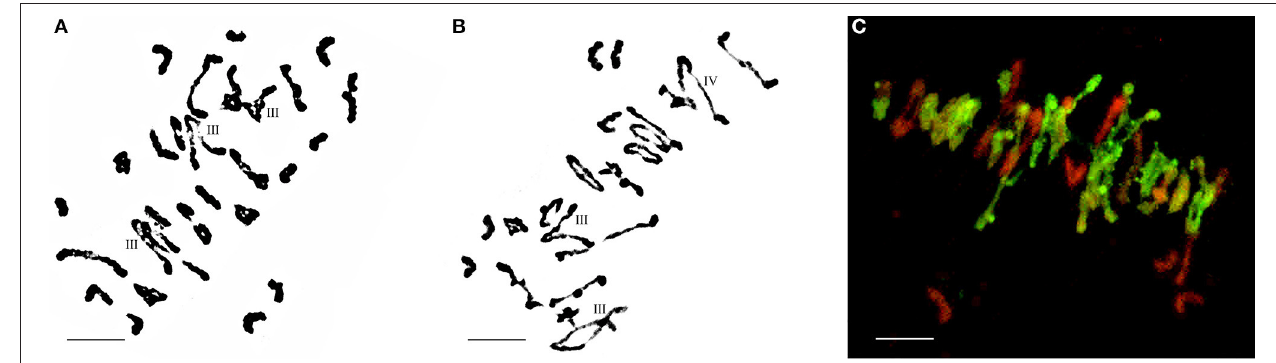
FIGURE 2 | Chromosome configuration of PMC MI in wheat- E. elongata F 1 hybrids. (A) Chromosome configurations of F 1 -1: 2 n = 7I + 20II + 3III; (B) Chromosome configurations of F 1 -2: 2 n = 6I + 20II + 2III + 1IV; (C) E. elongata chromosome configurations of F 1 -1: 2 n = 3I + 16II. Wheat chromosomes were detected in red and E. elongata chromosomes or chromosome segments were visualized in green. Bar = 10 µ